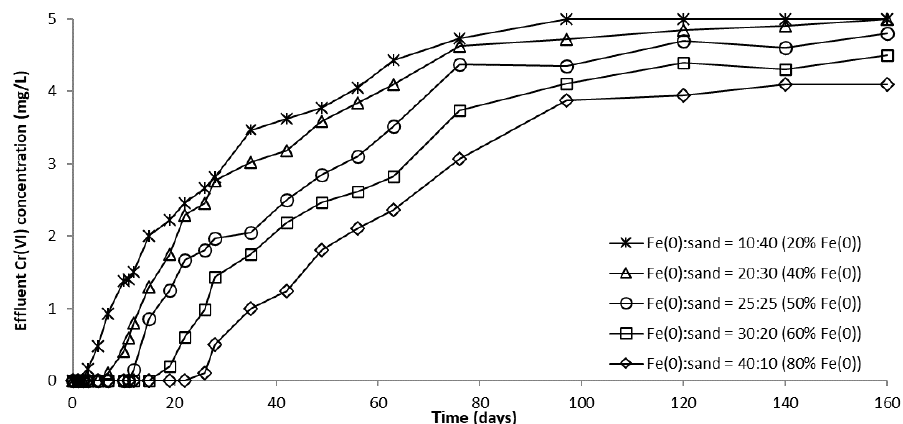
Figure 12. Cr VI concentration in column effluent vs. time for columns with “Fe 0 + sand” reactive zone having variable Fe 0 volume and fixed total volume V 2 .